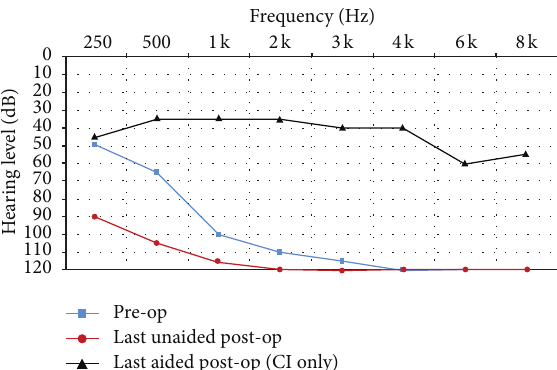
Figure 2: Audiometric results for Subject 2.